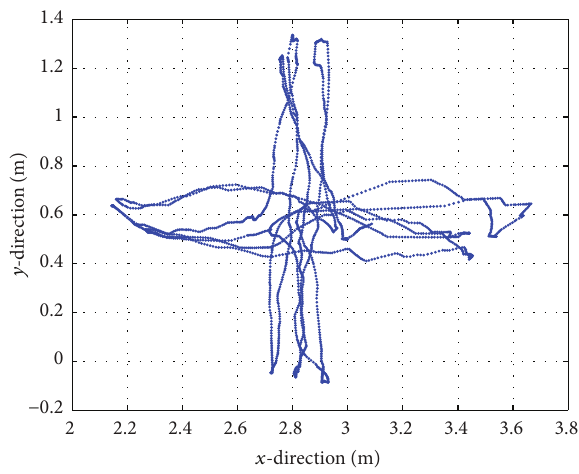
Figure 12: Location estimates of a moving